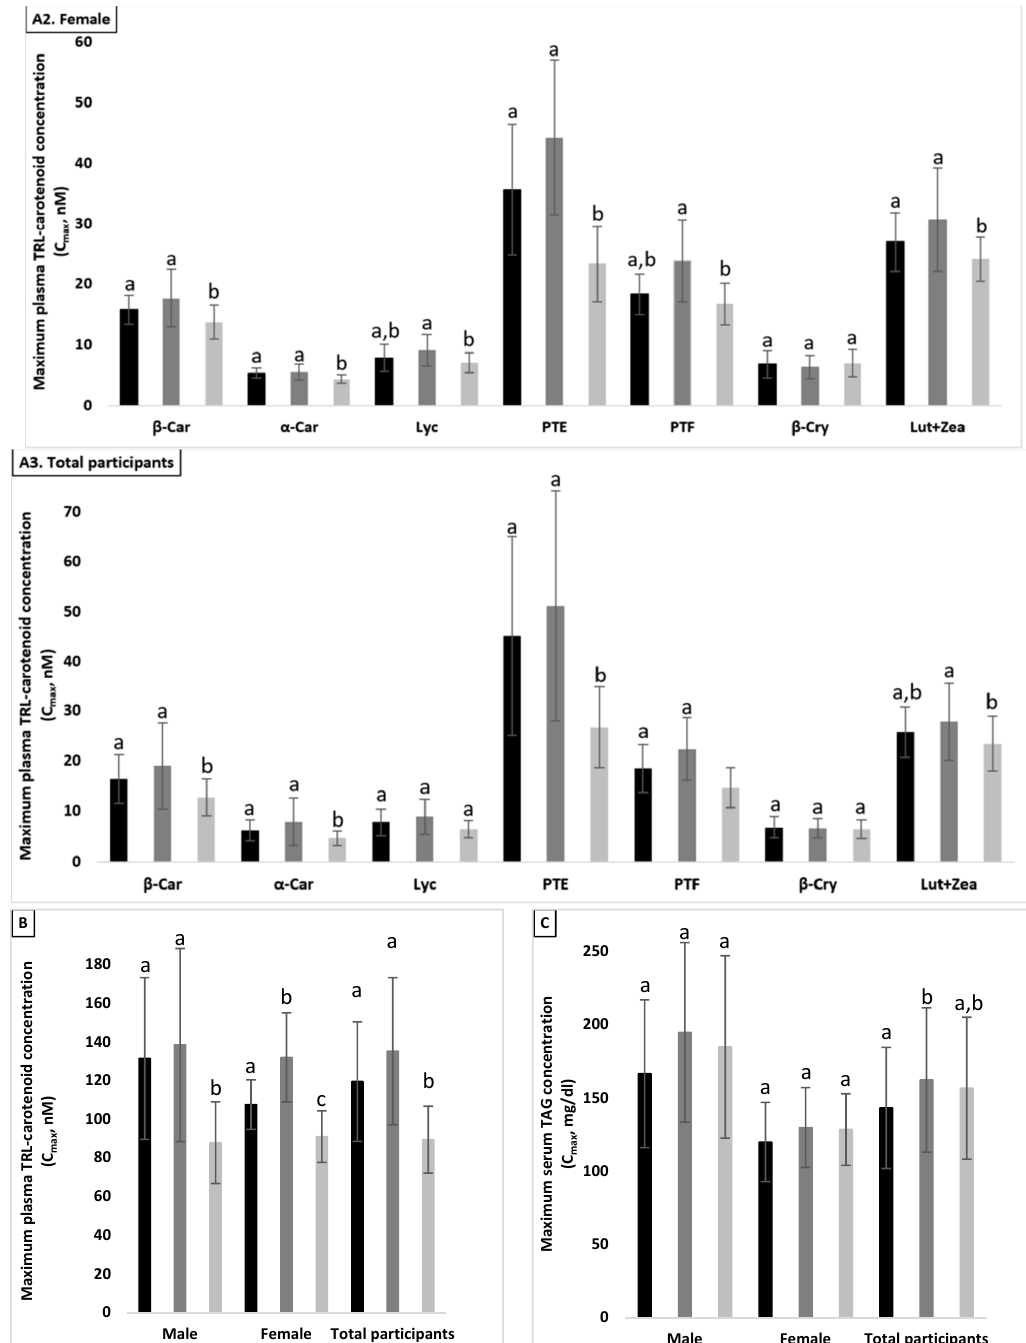
Figure 4. Effect of the tested meals on the maximum concentrations (Cmax) of postprandial plasma TAG-rich lipoprotein (TRL) carotenoids ( A , B ) and serum TAGs ( C ). Changes in Cmax of the plasma TRL-carotenoids and serum TAGs that reflect the highest concentrations measured, irrespective of the time point, following the consumption of the ■ control meal, ■ whey protein isolate (WPI-supplemented meal), or ■ soy protein isolate (SPI-supplemented meal). ( A ). individual carotenoid concentration (nM) in the plasma TRL fraction in male ( A1 ), female ( A2 ), and total participants ( A3 ); ( B ). total carotenoid concentration (nM) in the plasma TRL fraction; ( C ). serum TAG concentrations (mg/dL). Concentrations are expressed as mean values (total participants = 24, male/female = 12) with their standard errors. AUC were compared for statistically significant differences as outlined in the “Statistical Analyses” section. Columns labelled without a common superscript (alphabetic letters) differ significantly, p <